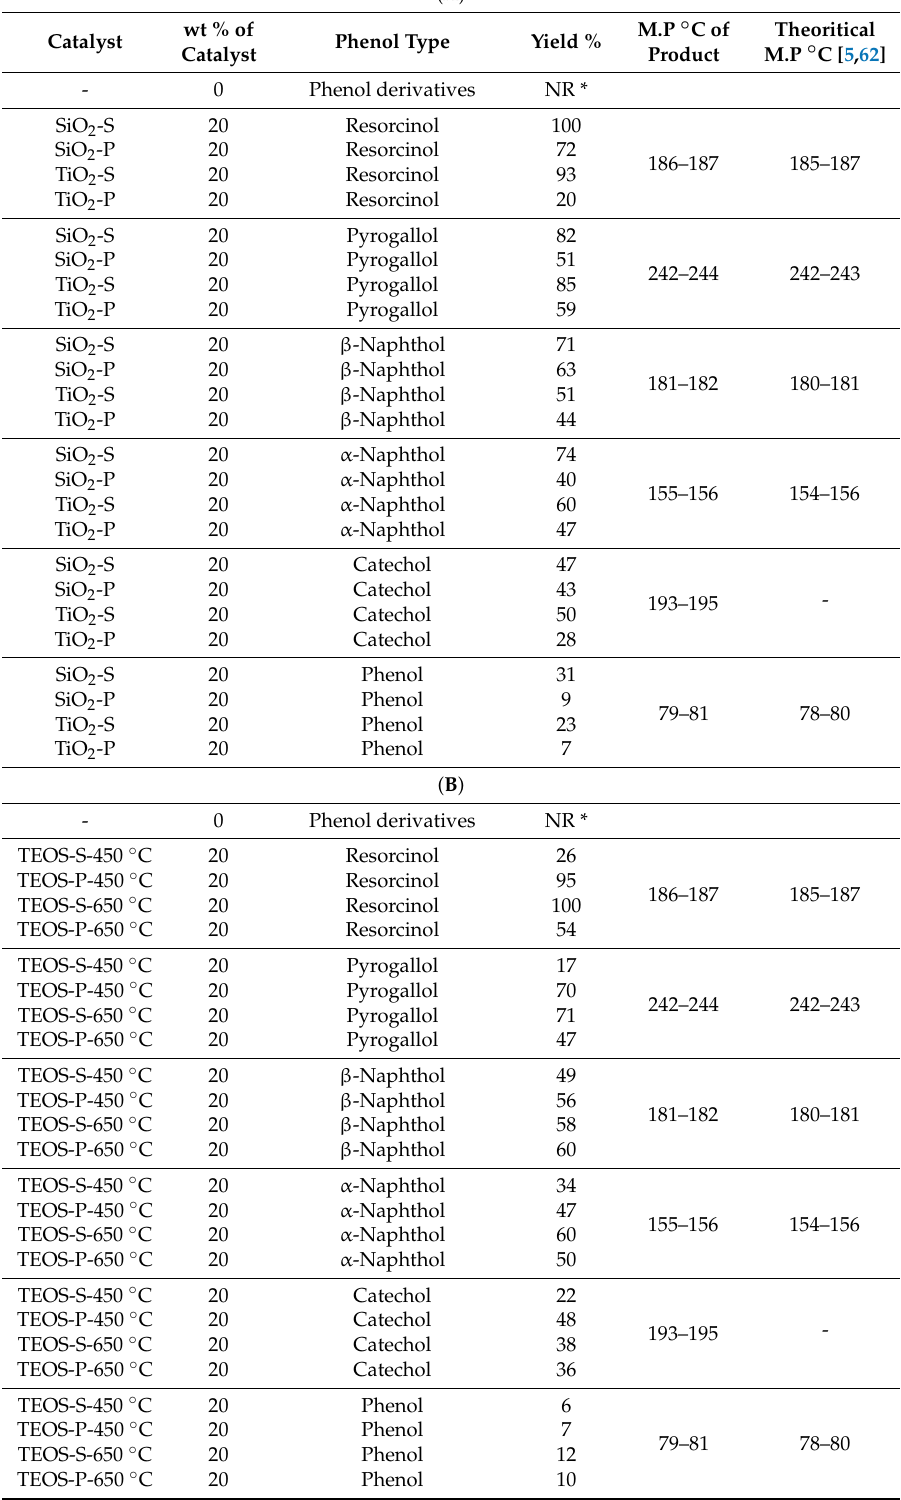
Table 2. ( A ) The catalytic conversion for the reaction of phenol derivatives (5 mM) and ethyl acetoacetate (10 mM) over sulfated and phosphated silica and titania catalysts carried out at reaction temperature 200 ◦ C and reaction time 4 h to produce coumarin derivatives. ( B ) The catalytic conversion for reaction of phenol derivatives (5 mM) and ethyl acetoacetate (10 mM) over sulfated and phosphated TEOS catalysts carried out at reaction temperature 200 ◦ C and reaction time 4 h to produce coumarin